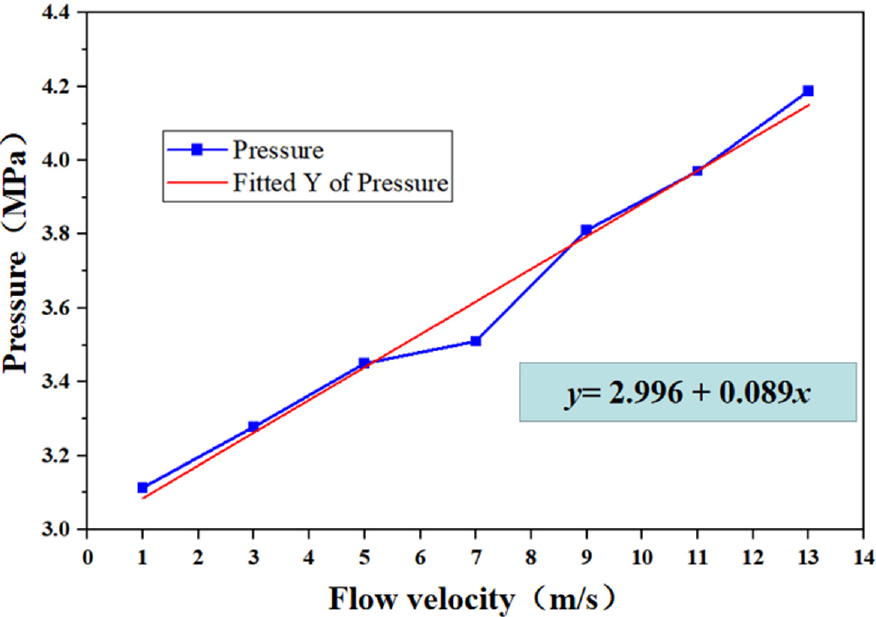
Figure 11. Relationship between maximum pressure of plugging agent and seawater flow velocity and mathematical model.